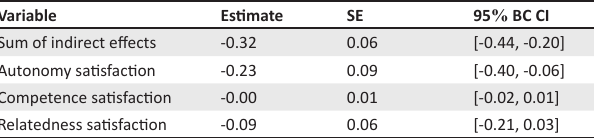
TABLE 5: Indirect effects of manager relations on turnover intention via psychological need